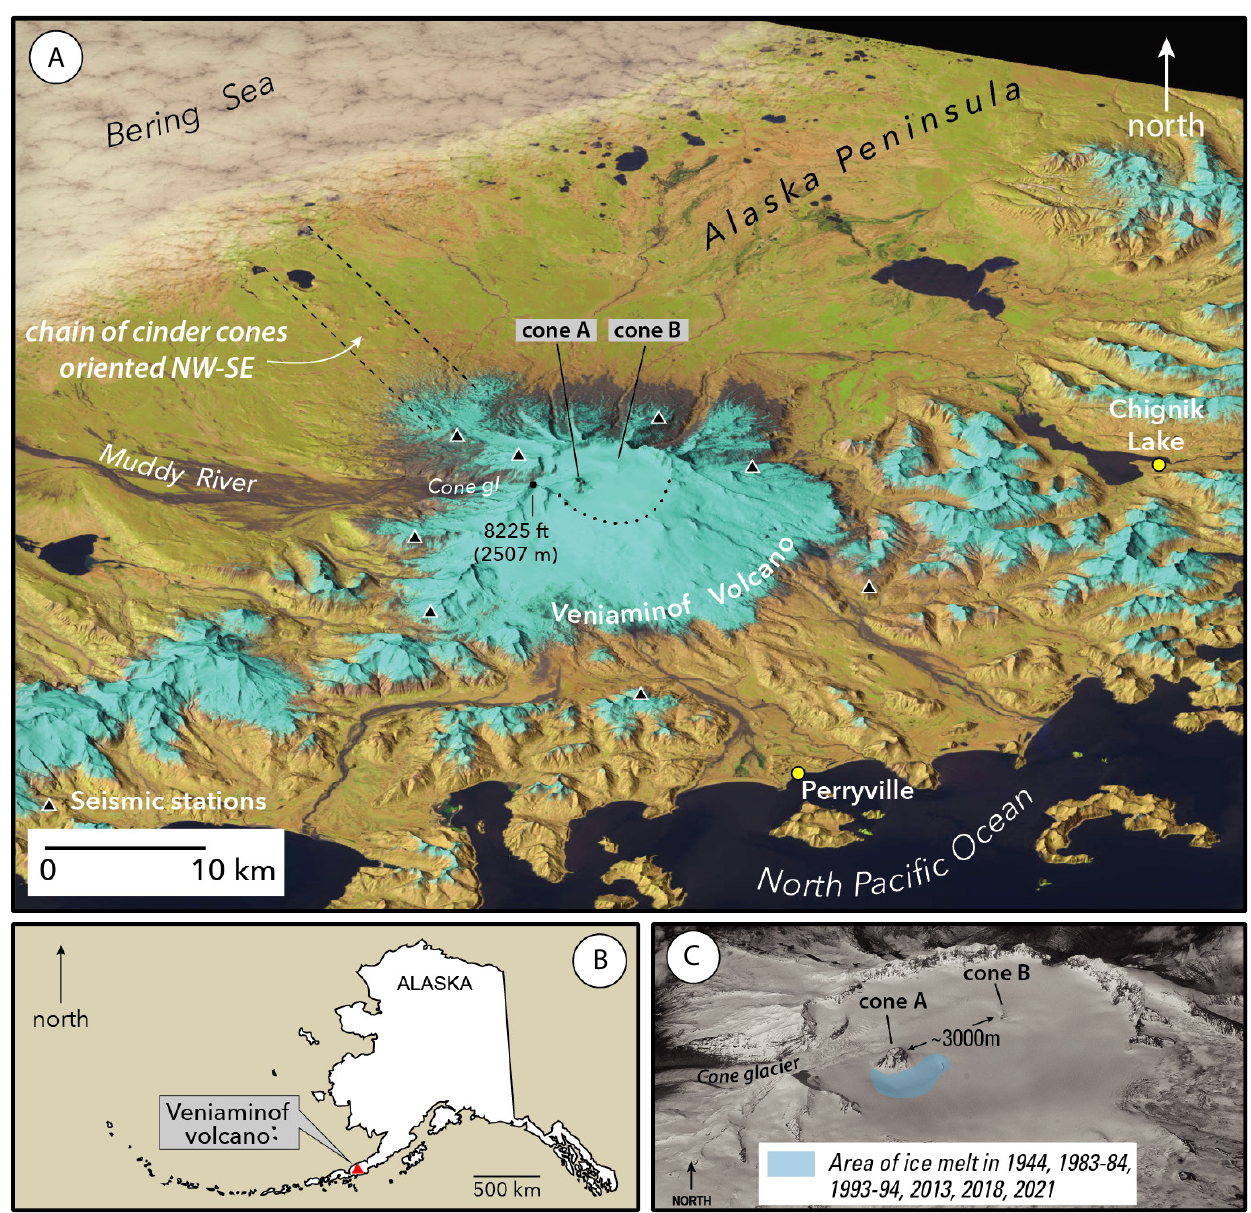
Figure 1: Location and setting of Veniaminof Volcano on the Alaska Peninsula. [A] Shaded relief image of Veni- aminof Volcano and vicinity showing location of intracaldera cones A and B. Cone A has been the site of all known historical eruptive activity. Cone B is an older intracaldera cone that is mostly covered by ice and snow and has had no known historical eruptions. Black triangles indicate seismic stations on the volcano; the seismic network has been operated by AVO since 2002. Dotted line shows approximate location of ice-covered caldera rim. [B] Location of Veniaminof Volcano on the Alaska Peninsula of southwest Alaska. [C] Oblique aerial photograph of the 8 ˆ 10 km diameter ice-filled caldera and areas inundated by lava flows in 1983–1984, 1993–1994, 2013, and